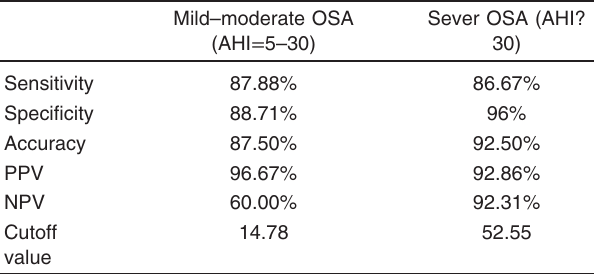
Table 4 Validity of predicted cutoff values for diagnosis of OSA depending on ODI of overnight pulse oximetry